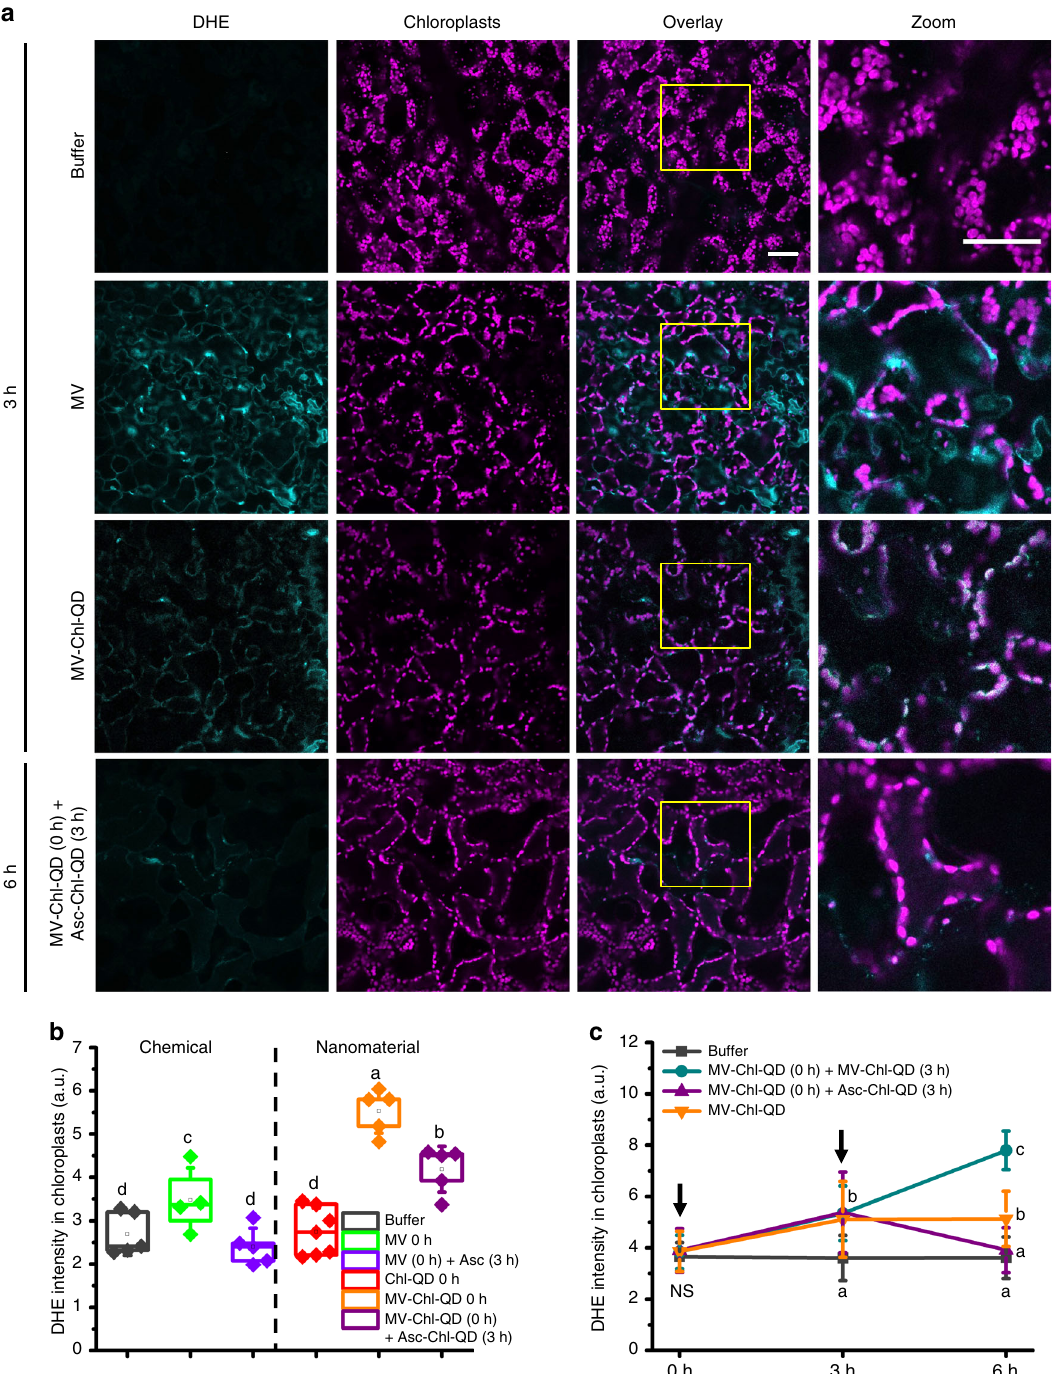
Fig. 6 Chloroplast speci fi c subcellular tuning of oxidative status by targeted delivery of nanoparticles with biochemical cargoes. a Confocal microscopy images of Arabidopsis leaf mesophyll cells illustrating the targeted generation and scavenging of superoxide anion (detected by DHE fl uorescent dye) in chloroplasts by MV-Chl-QD and Asc-Chl-QD guided by peptide recognition motifs, respectively. Scale bar, 40 µ m. b Comparison between chemical and nanotechnology-based approaches for speci fi cally increasing superoxide in chloroplasts. DHE was used as an indicator for superoxide ROS levels after 6 h. Chemicals and nanomaterials were treated at the time points speci fi ed in the legend. Box plot error bars represent standard deviation, boxes are the interquartile range from the fi rst to the third quartile with squares as the medians, and horizontal line represents the mean. c Temporal patterns of DHE fl uorescence signal intensity inside chloroplasts in leaf mesophyll cells showing the speci fi c increase and subsequent decrease of chloroplast superoxide anion levels in plants in fi ltrated with MV-Chl-QD ( n = 4) at time 0 h and subsequently perfused with Asc-Chl-QD at time 3 h (purple line). A steady increase in DHE intensity was observed in leaves treated with MV-Chl-QD at time 0 h and 3 h ( n = 5) (cyan line). Leaves in fi ltrated with MV-Chl-QD ( n = 4) at time 0 h only (orange line) showed an increase in DHE signal that plateaus. Controls were performed for leaves in fi ltrated only with buffer ( n = 5) (dark gray line). Values are means and ± indicates standard deviation. Statistical comparisons were performed by one-way ANOVA based on Duncan ’ s multiple range test (two tailed). Lower case letters represent signi fi cance at P < 0.05. NS denotes not signi fi